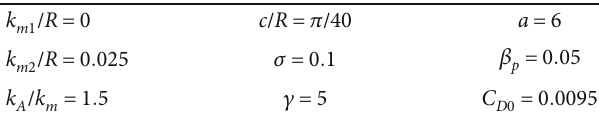
Table 1: Values of parameters of uniform blade for numerical